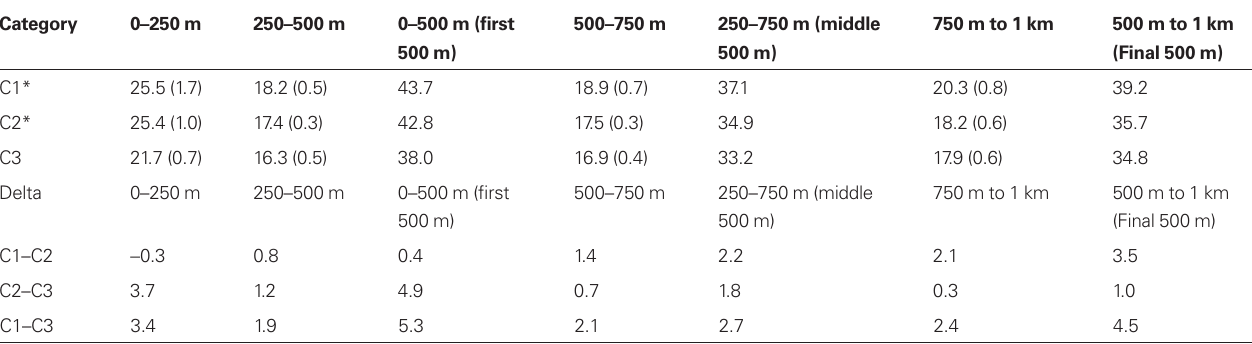
Table 1 | Lap time (in seconds) to realize the best performance ( ± SD) of 1-km standing start for C1–C3 categories and the interclass time difference (delta, s) measured during the UCI World Para-cycling Track championships in 2011.